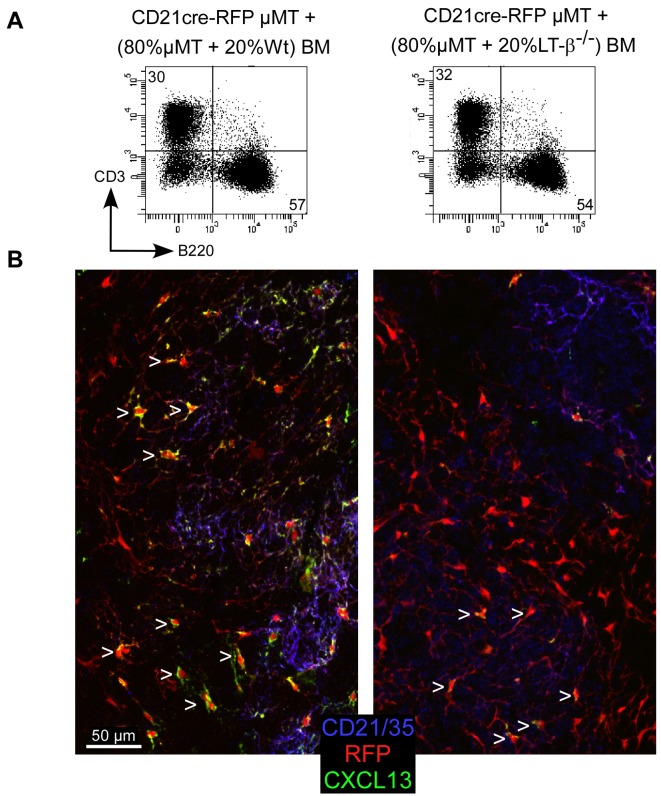
LT-β expression on B cells regulates CXCL13 expression in CD21− RFP+ stromal cells.CD21cre-RFP μMt−/− mice were irradiated and reconstituted with a mixture of μMt−/− (80%) and Wt (20%) bone marrow cells or a mixture of μMt−/− (80%) and LT-β–deficient bone marrow cells. Reconstituted chimeras were injected with an emulsion of CFA/PBS in the ears. Three weeks later, splenocytes were used to assess the percentage of CD3+ T cells and B220+ B cells in each group of mice by flow cytometry (A). Ear draining LNs were sectioned and stained for CD21/35 (blue), CXCL13 (green), and B220 expression (B). Confocal pictures were taken in B220+ B cell follicles. RFP+ cells appear in red. Arrowheads point to CXCL13+ CD21− RFP+ stromal cells. Data are representative of two different experiments (three mice per experiment).